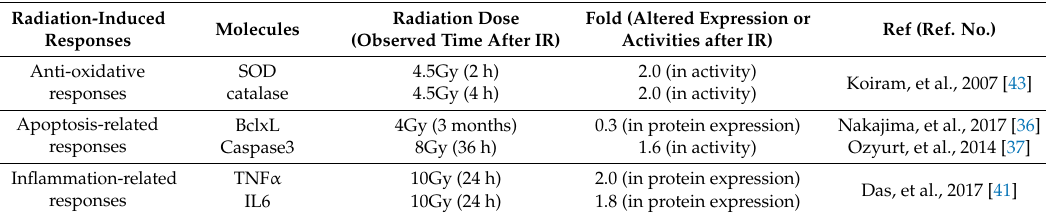
Figure 1. Radiation-induced responses in the liver. Table 1. Alterations in representative molecule expression or activities after irradiation (IR).